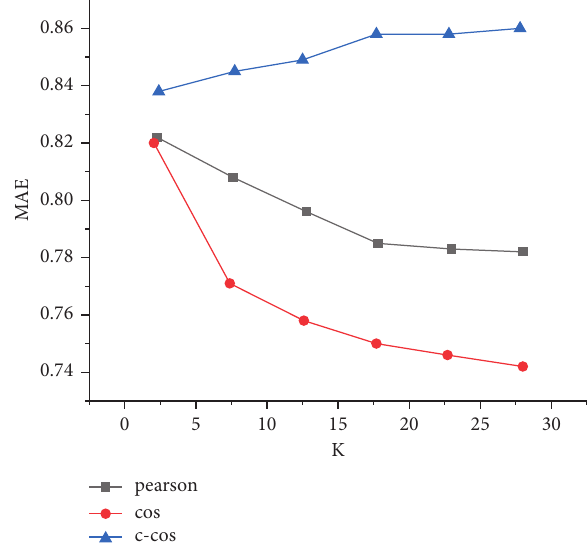
Figure 1: MAE of the three-phase velocity measurement methods varies with the number of nearest